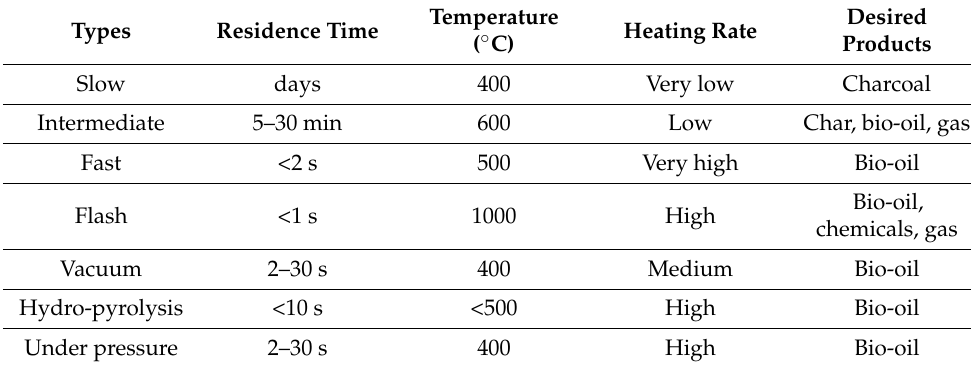
Table A2. Types of pyrolysis with primary distinguishing parameters.